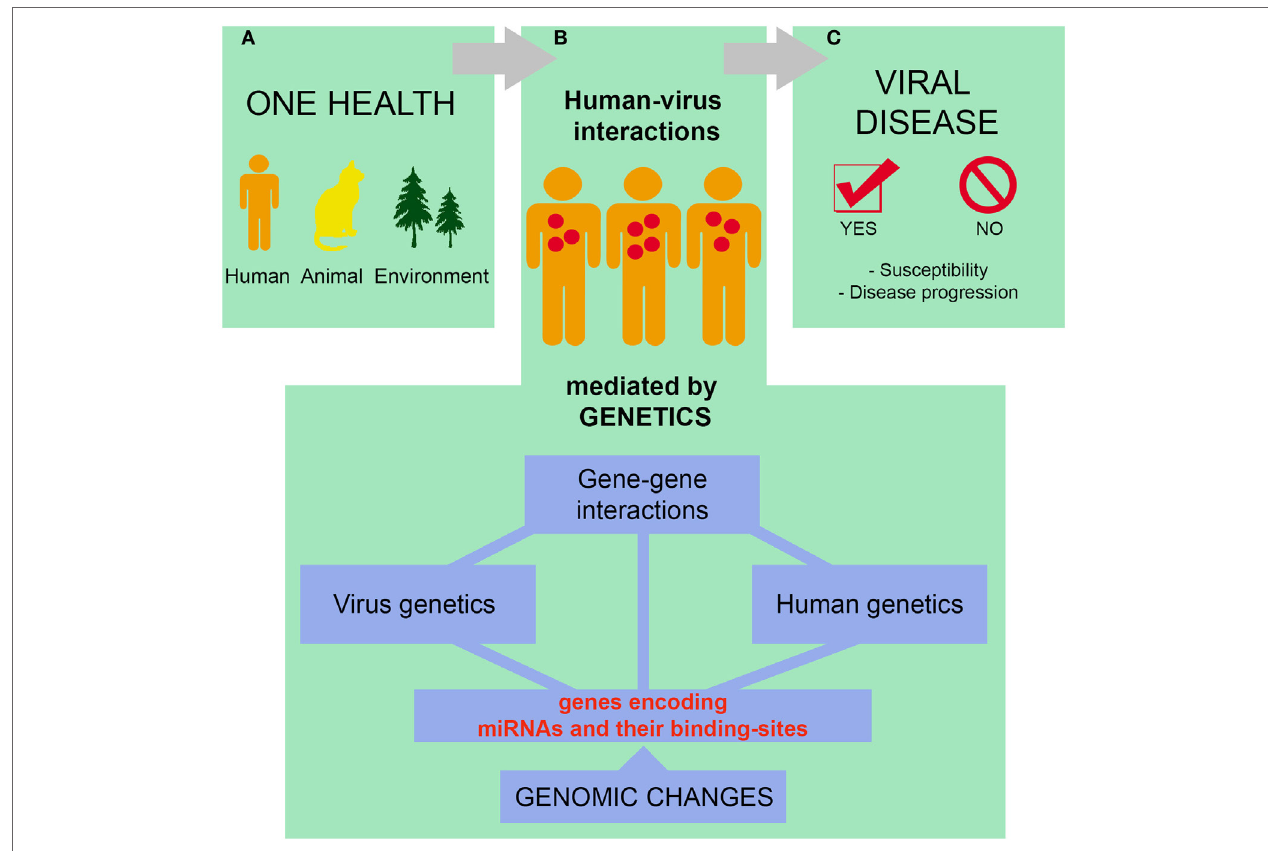
FiGURe 3 | Susceptibility to infections and progression of viral diseases are complex processes that must be thought within the context of One Health. Human, non-human, and environmental factors define whether a given individual will come into contact with a particular virus and the consequences of such interaction (A) . Of note, human–virus interactions are mediated by both host and viral genetic factors, including microRNAs (miRNA) and miRNA-related polymorphisms (B) . The complex interactions mentioned in (A,B) influence the susceptibility to infections as well as the progression of viral diseases (C) . See text for